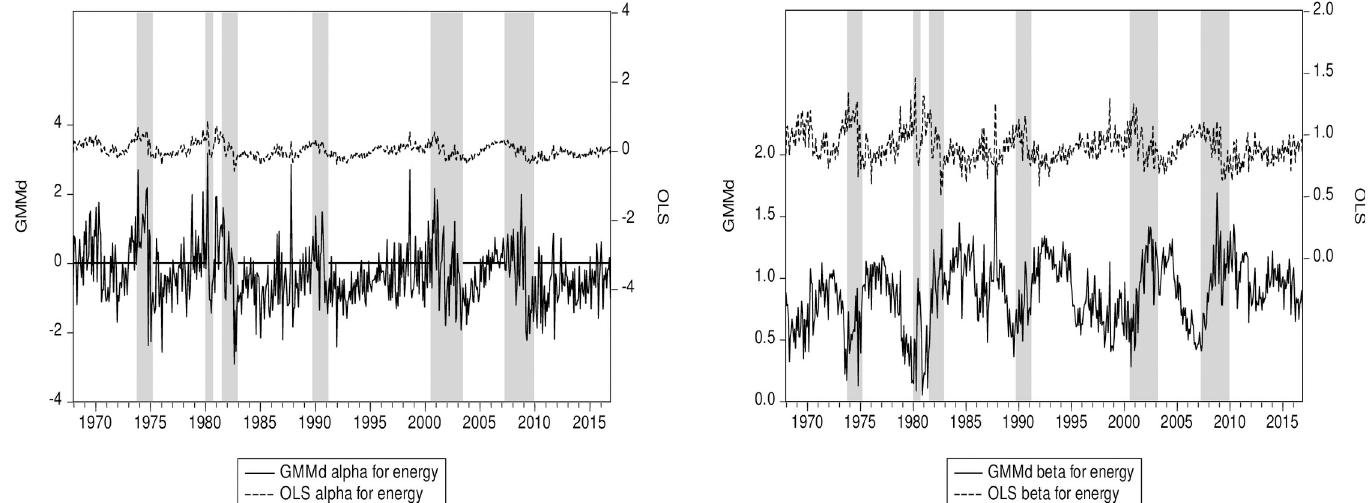
Fig 3. (a) Energy alpha for RIV GMM and OLS. (b) Energy beta for RIV GMM and OLS. Notes: The energy sector has the highest value of the OLS factor loading for illiquidity IML . RIV GMM (GMMd) is our robust instrumental variables approach. Shaded areas represent US recessions or crises. The OLS and GMM series are plotted on the same scale.